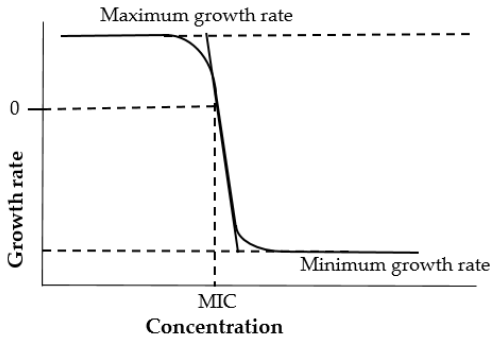
Figure 8. Schematic representation of time-kill curve.